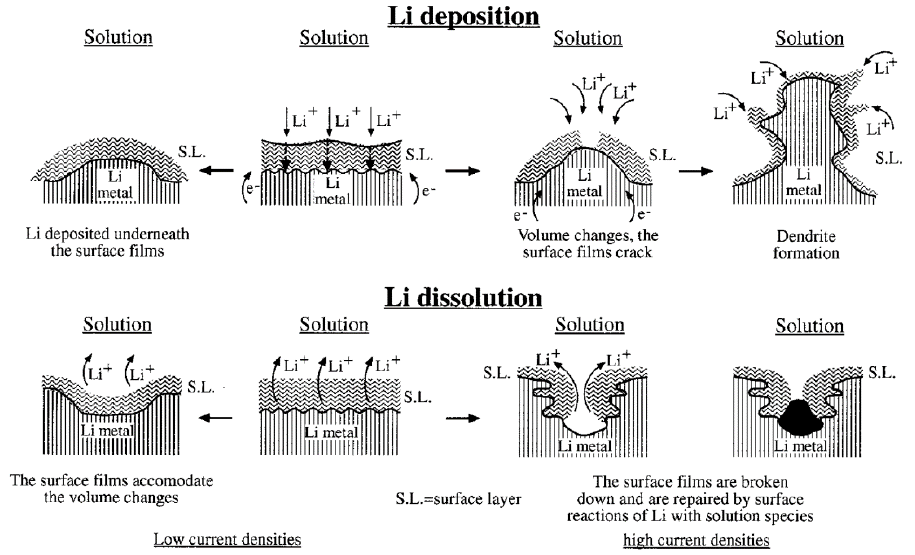
Figure 5. Description of the morphology and failure mechanism of Li electrodes during Li deposi- tion and dissolution, with dendrite formation and heterogeneous Li dissolution accompanied by surface film destruction and repair [66]. film destruction and repair